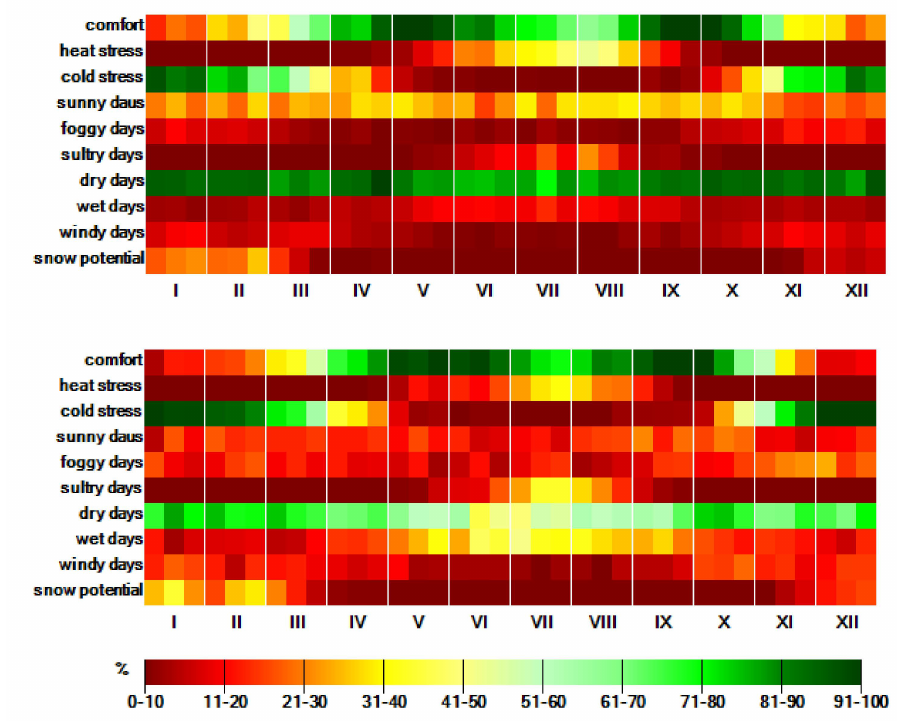
Figure 12. CTIS in Kłodzko for anticyclonic (top) and cyclonic (bottom) types of circulation in 1971–2010.